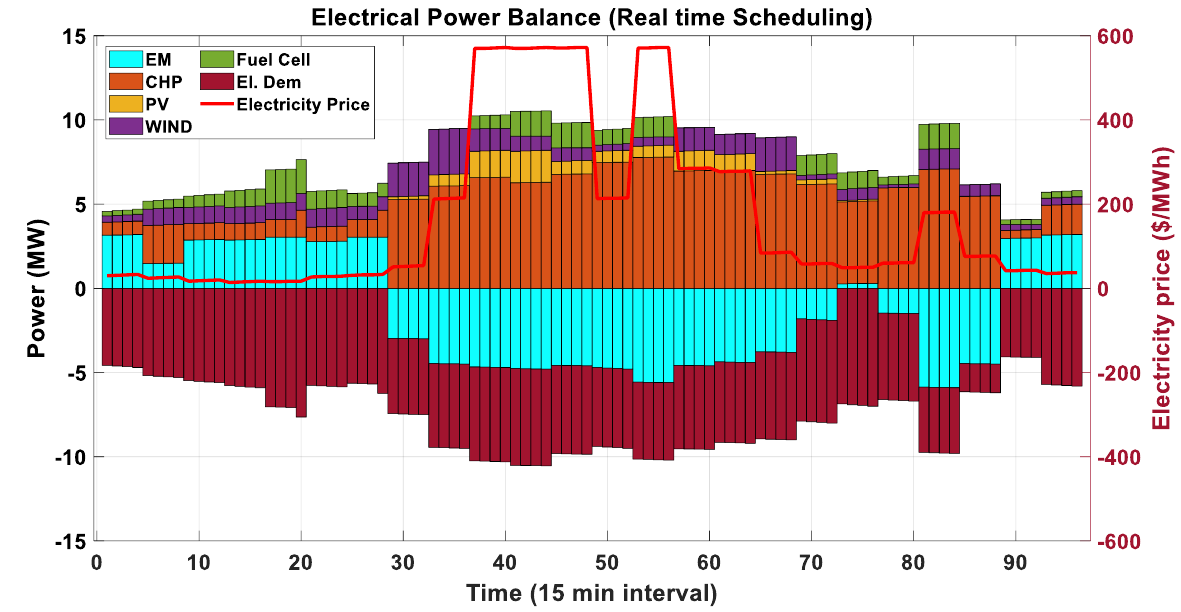
Figure 19. Case II power balance (electrical) in the VPP network for 15-min.